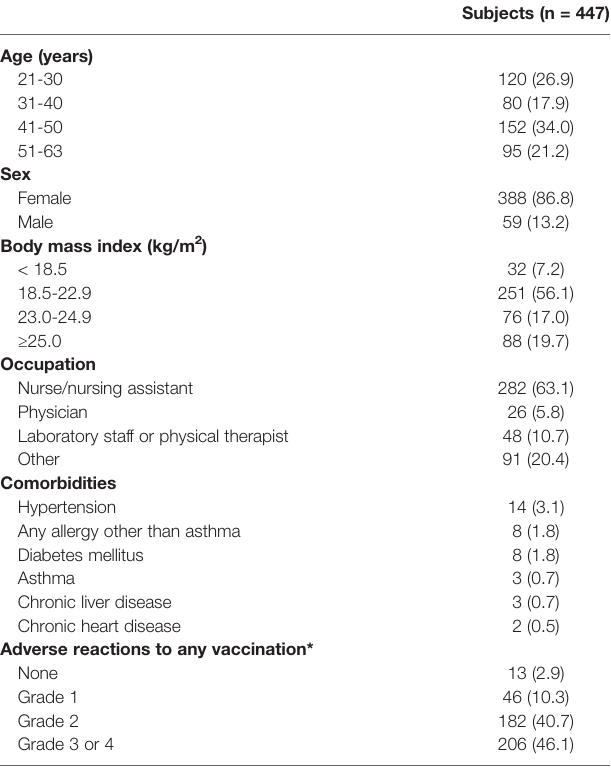
TABLE 1 | Characteristics of the study